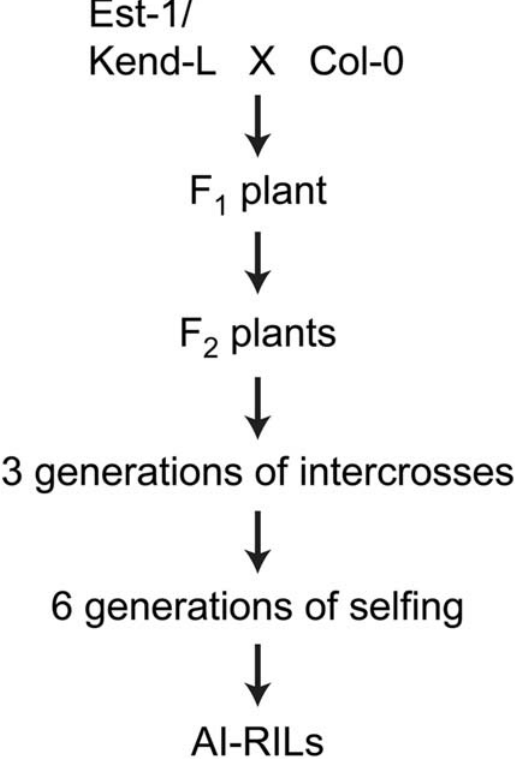
Figure 1. Diagram of the generation of AI-RILs. Intercrosses were between non-overlapping